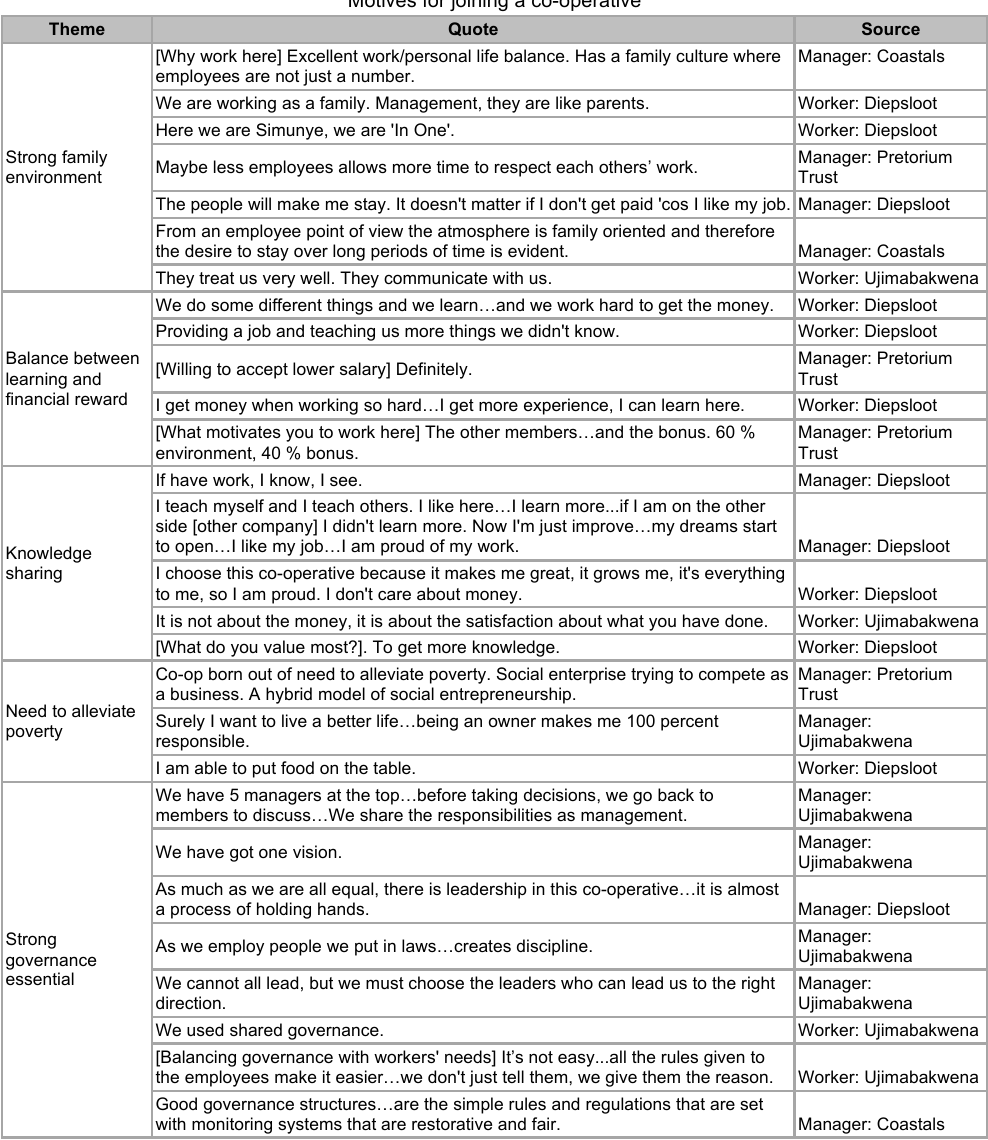
Table 4 Motives for joining a